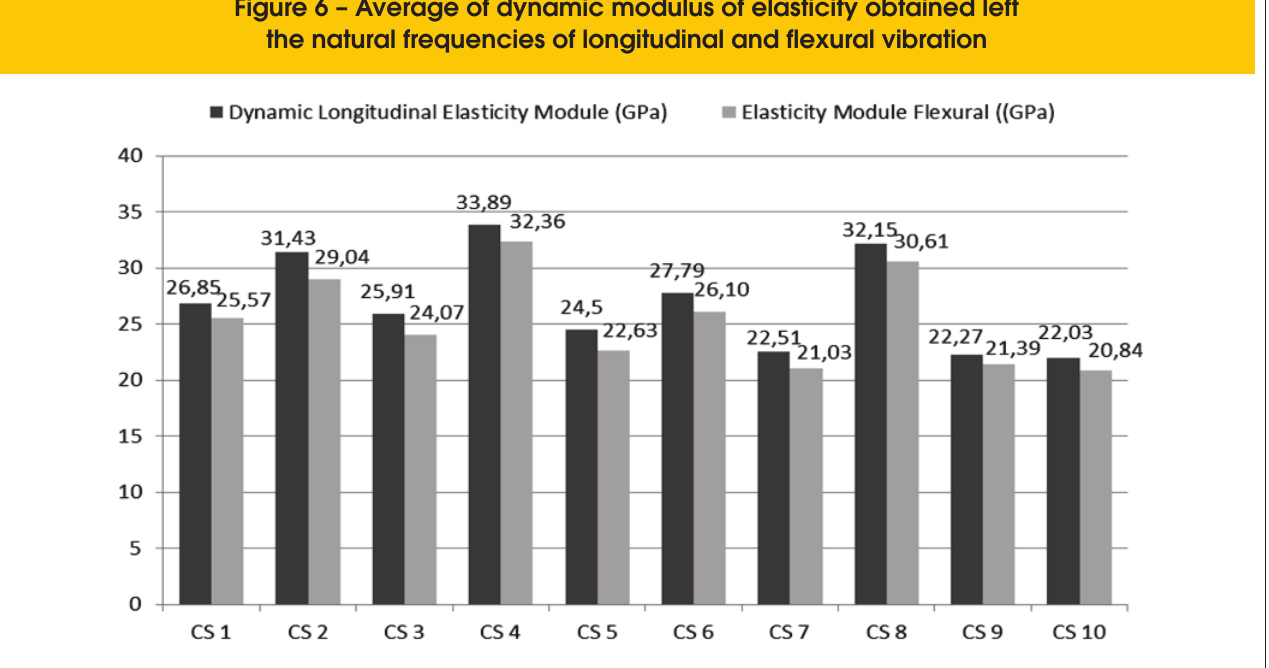
Figure 6 – Average of dynamic modulus of elasticity obtained left the natural frequencies of longitudinal and flexural